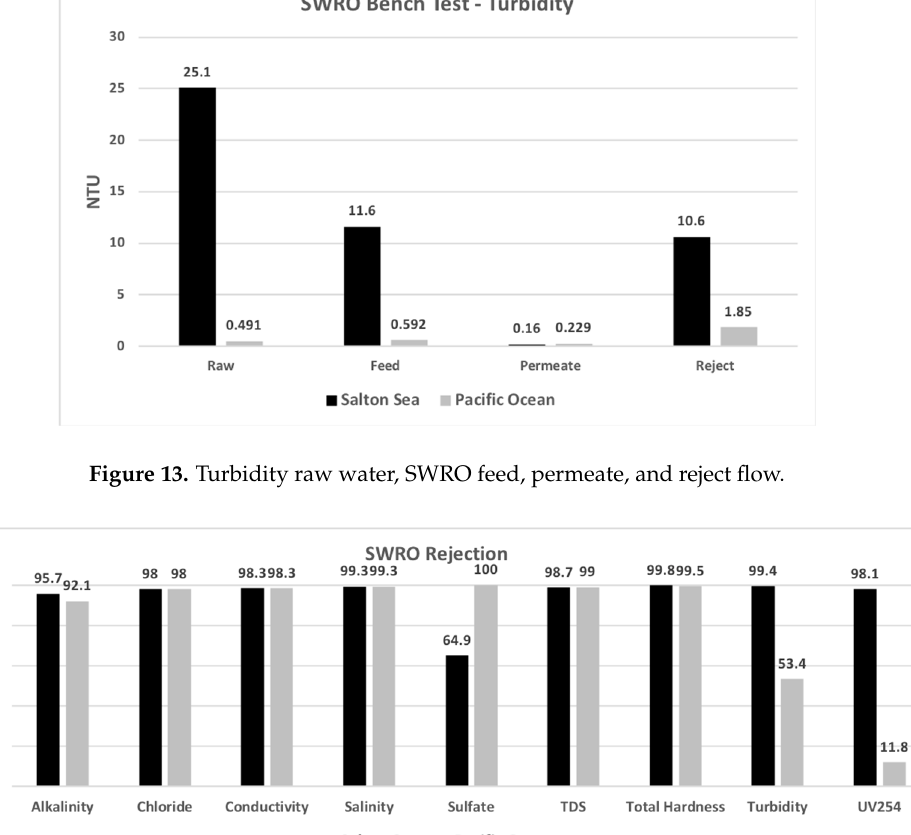
Figure 12. Sulfate of raw water, SWRO feed, permeate, and reject flow.